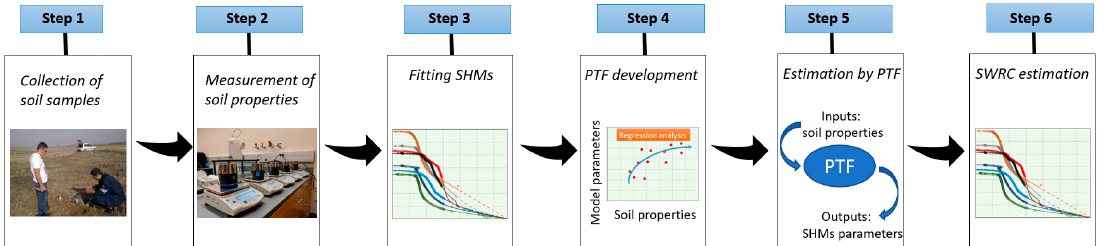
Figure 1. Schematic illustrations of the data collection, pedotransfer function (PTF) development and SWRC estimation workflow used in this study. SHM: soil hydraulic models, SWRC: soil water retention curve.